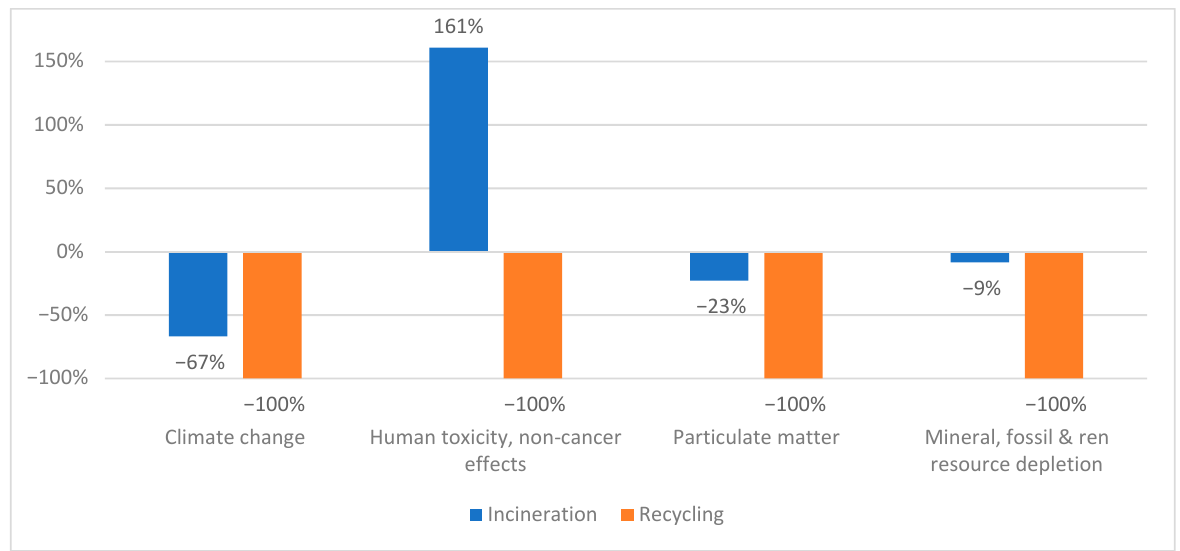
Figure 6. Percentage difference between impacts of recycling and incineration scenarios (the lowest value is fixed as − 100%). A negative value means an environmental benefit, a positive value means an environmental impact.